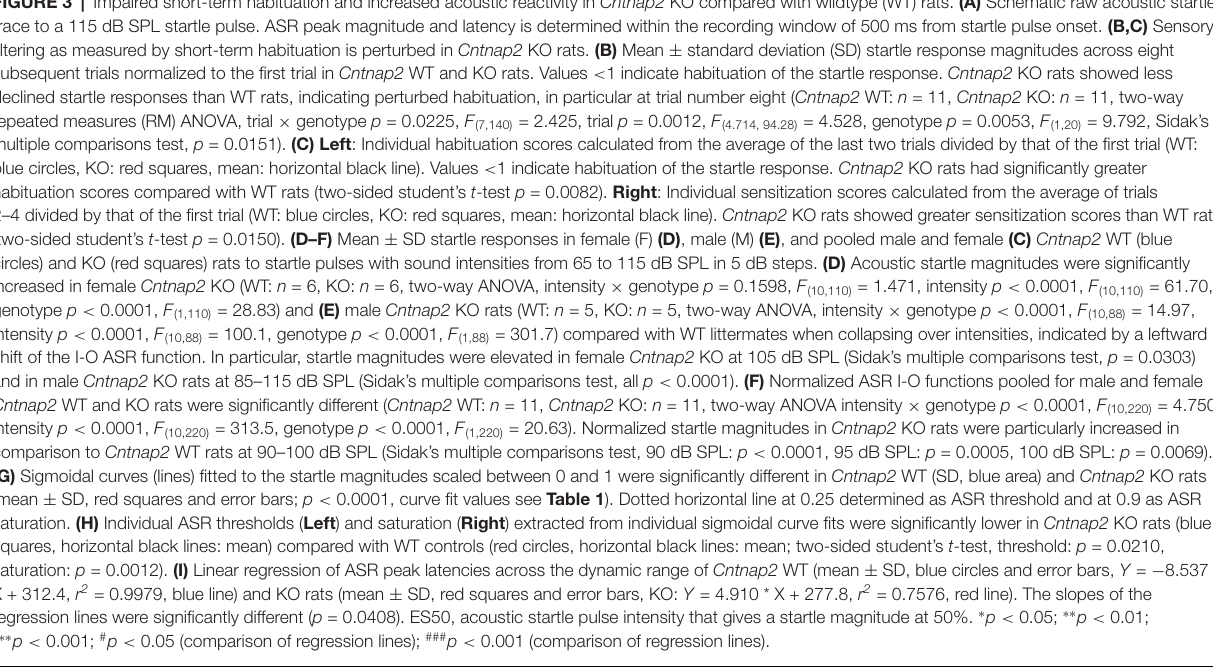
This means that, on average, Cntnap2 KO rats reach the 25% and 90% criterion at lower startle pulse intensities than WT rats—further indicators for the left-shift of the ASR I-O function and increased acoustic reactivity in Cntnap2 KO rats. Taken together, the ASR I-O functions and their parameters extracted from the sigmoidal curve fits demonstrated increased ASR capacity (maximal response possible), stimulus potency (ES50),